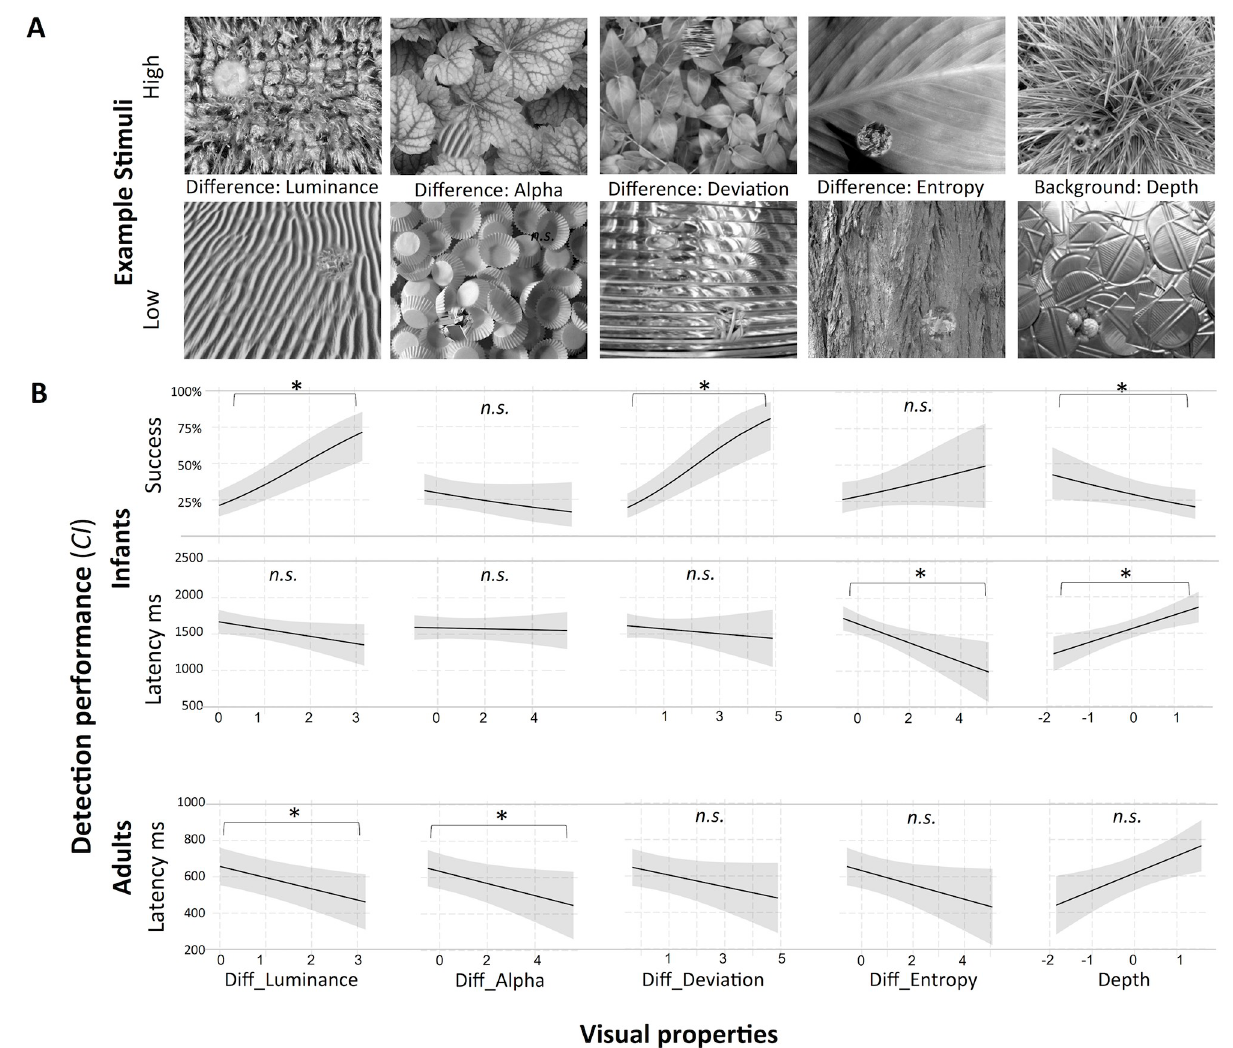
Fig 5. Structure-related visual properties and their effect on search performance. (A) Examples of search stimuli with the respective low and high values of visual properties that contributed significantly to any of the models. (B) Visual properties as functions of search performance and participant group, estimated as marginal effects in the models. Asterisks indicate significant contributions of the variable to the full models, see Table 4. Diff_luminance is estimated as single variable together with the covariates of the respective model groups (i.e., infants: movement; adults: movement,